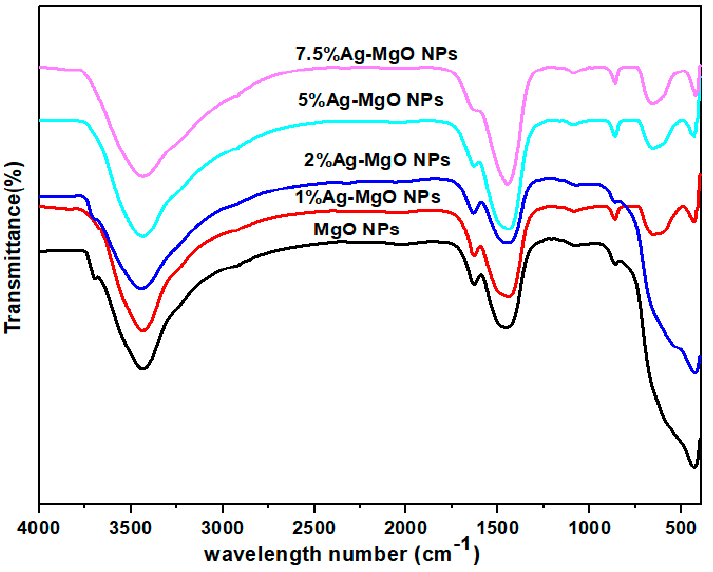
Figure 7. FTIR spectra of pure, 1%Ag ‐ MgO, 2% Ag ‐ MgO, 5% Ag ‐ MgO, and 7.5 %Ag ‐ MgO NPs.